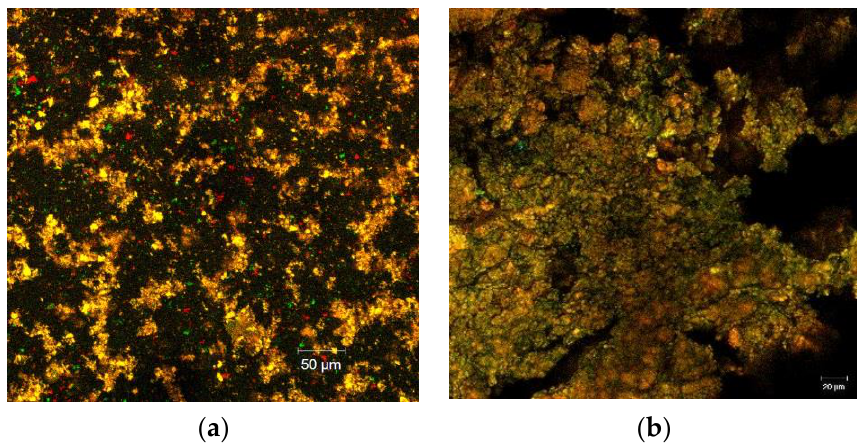
Figure 1. Confocal laser scanning microscopy images of the two powder samples obtained with the ZEN 2012 SP1 software (Black Edition) by encapsulating the flavonoids extracted from the yellow onion skins within different materials: Variant 1 — WPI:WHP:MD:P — 2:0.5:1:0.5 ( a ), Variant 2 — WPI:MD:P — 2:1:0.5 ( b ).